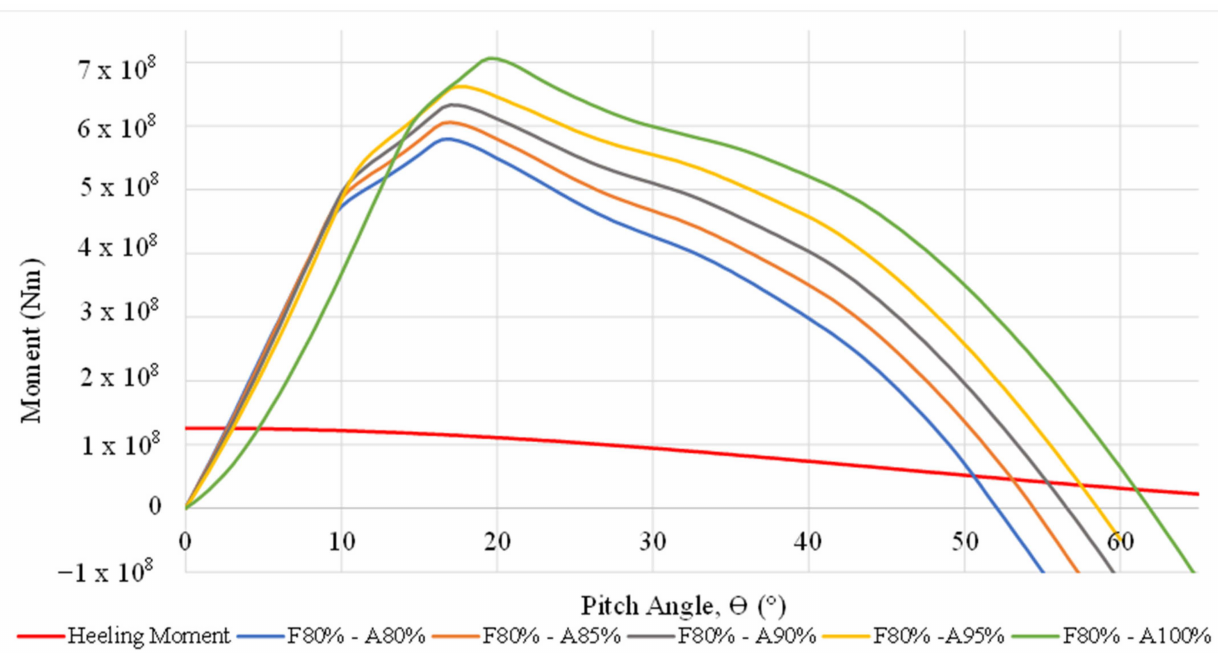
Figure 13. Shift in LCF position due to partial ballasting.